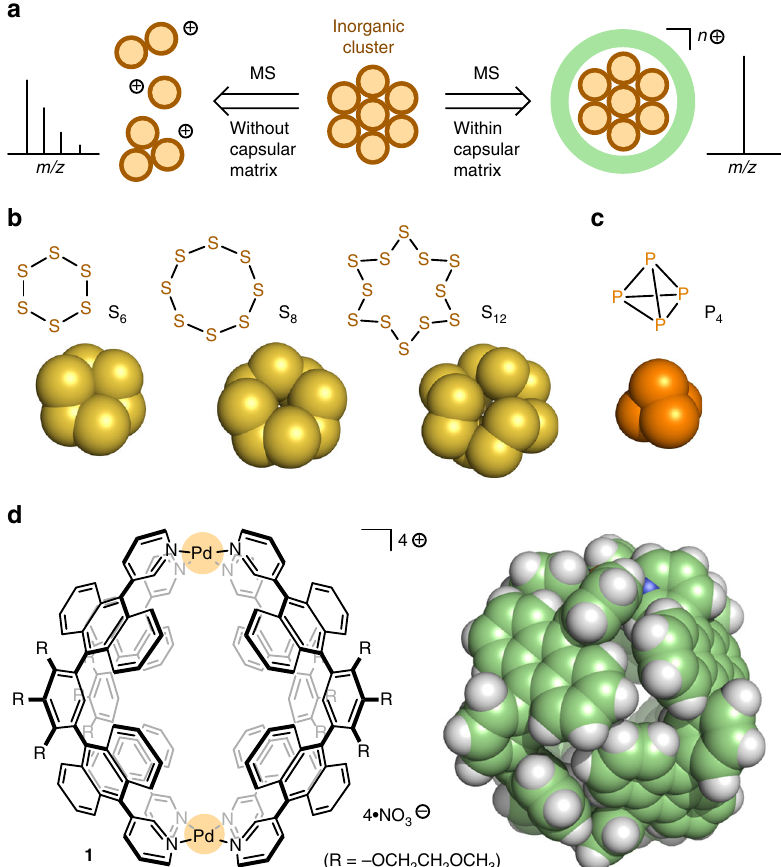
Fig. 1 MS analysis of an inorganic cluster and structure of sulfur clusters and polyaromatic capsule 1 . a Schematic representation of the MS analysis of a neutral inorganic cluster within/without a capsular matrix and their typical ion peaks. b Sulfur clusters S 6 , S 8 , and S 12 and their crystal or optimized structures. c White phosphorus and its crystal structure 37 . d Polyaromatic capsule 1 and the space- fi lling representation of the crystal structure (substituents and counterions are omitted for